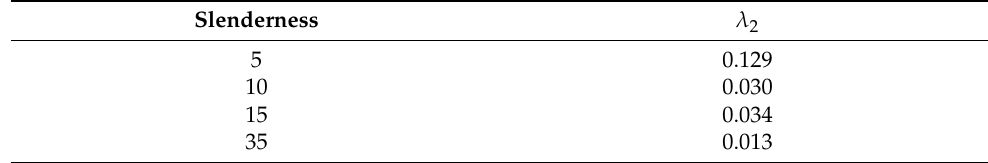
Table 1. λ 2 values for the computation of the out-of-plane capacity of infill walls (FEMA 273